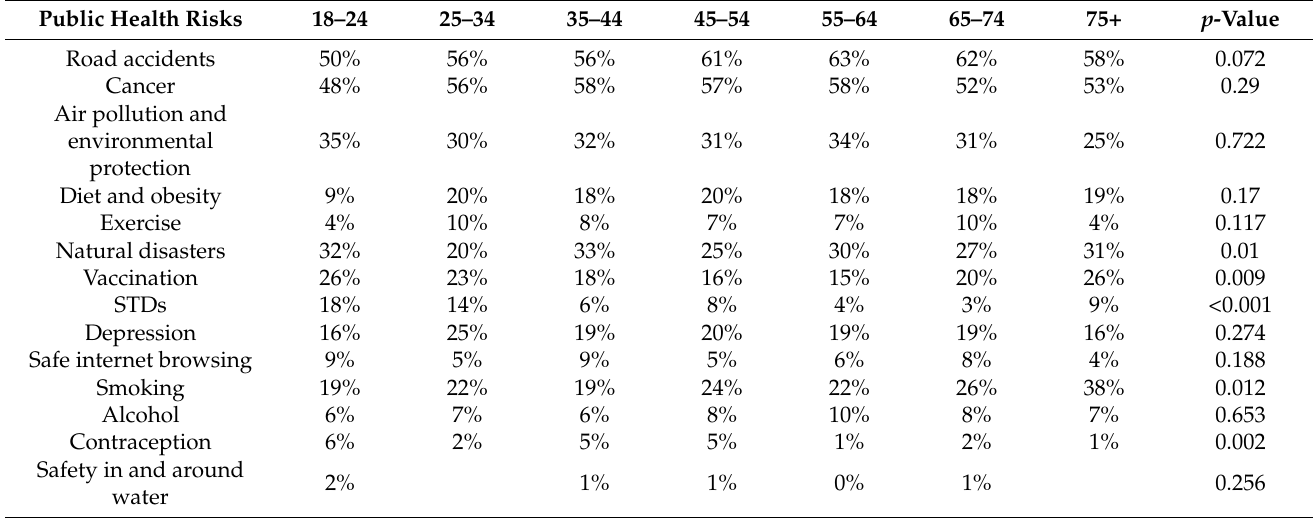
Table 5. Most important public health risk by age (up to 3 answers per participant).